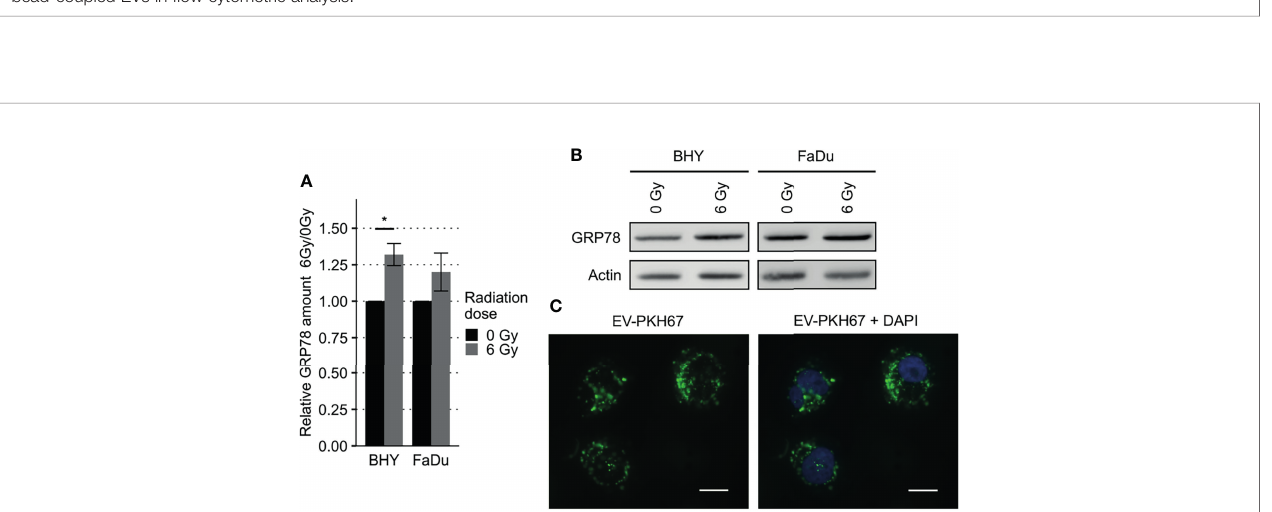
FIGURE 7 | Increased GRP78 expression in HNSCC EV recipient cells. (A, B) Western Blot analysis with representative blot (B) of GRP78 expression in EV recipient cells show increased amounts of GRP78 in 6Gy-EV recipient cells. GRP78 expression was normalized to beta-actin and 0Gy-EV recipient cell GRP78 expression served as baseline (n = 3, t-test, *p < 0.05). (C) Fluorescence microscopy images of BHY cells co-cultured with PKH67-stained EVs documenting uptake. Stained vesicle membranes are shown in green. Recipient cell nuclei are shown in blue. White size bar indicates 20